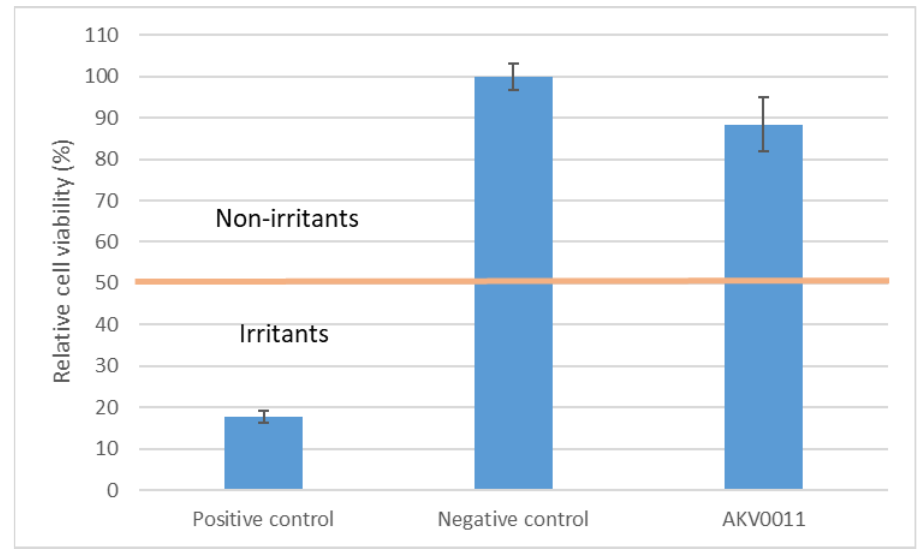
Figure 8. Viability of test item AKV011 in comparison with positive and negative controls after in vitro eye irritation test (percentage of negative control ± SEM).